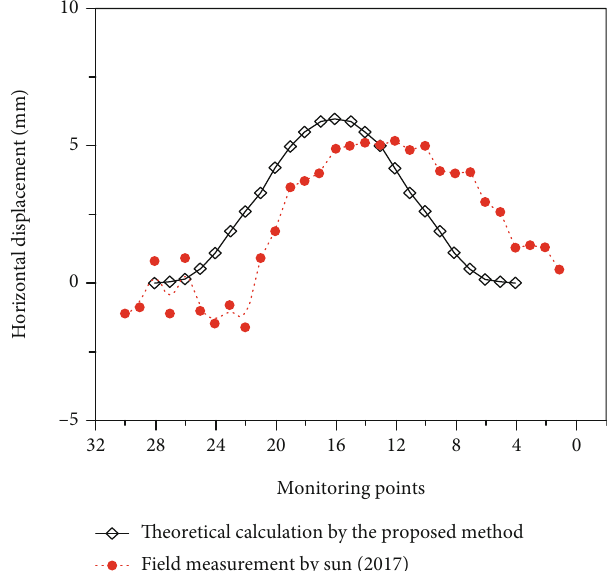
Figure 7: Excavation-induced tunnel horizontal displacements for the HBOB